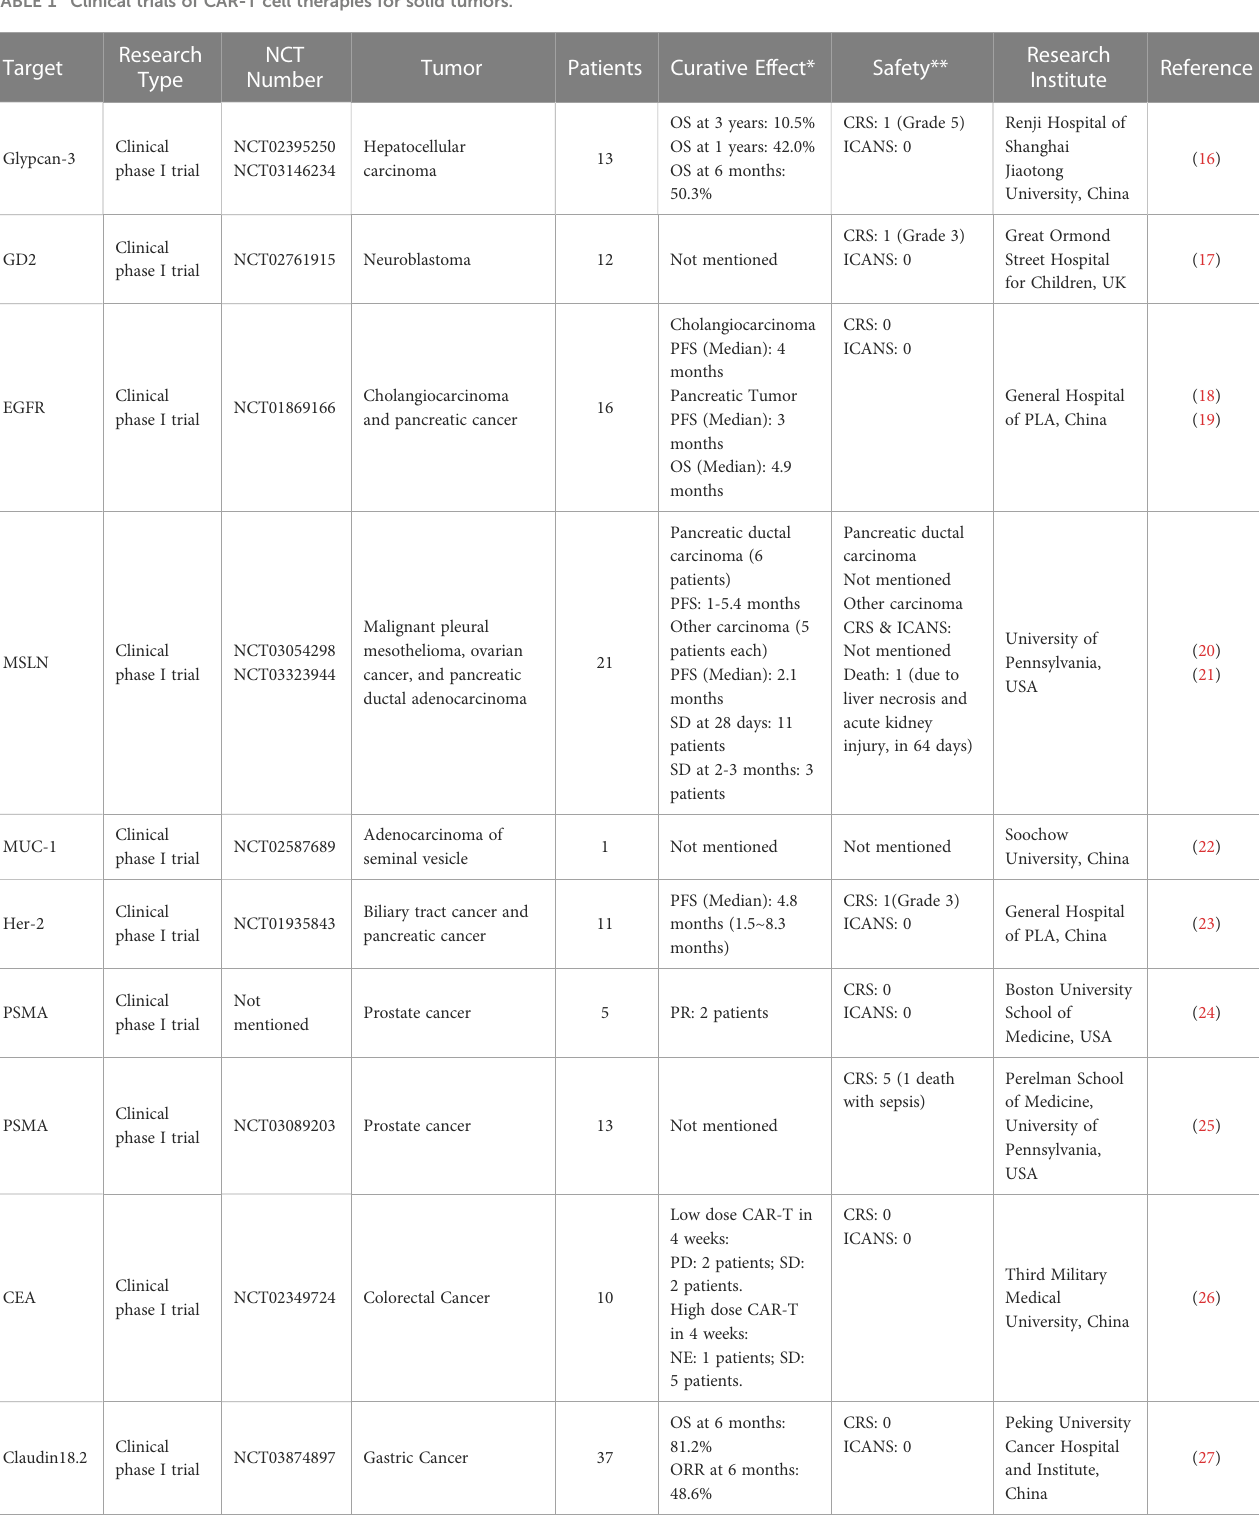
TABLE 1 Clinical trials of CAR-T cell therapies for solid tumors.